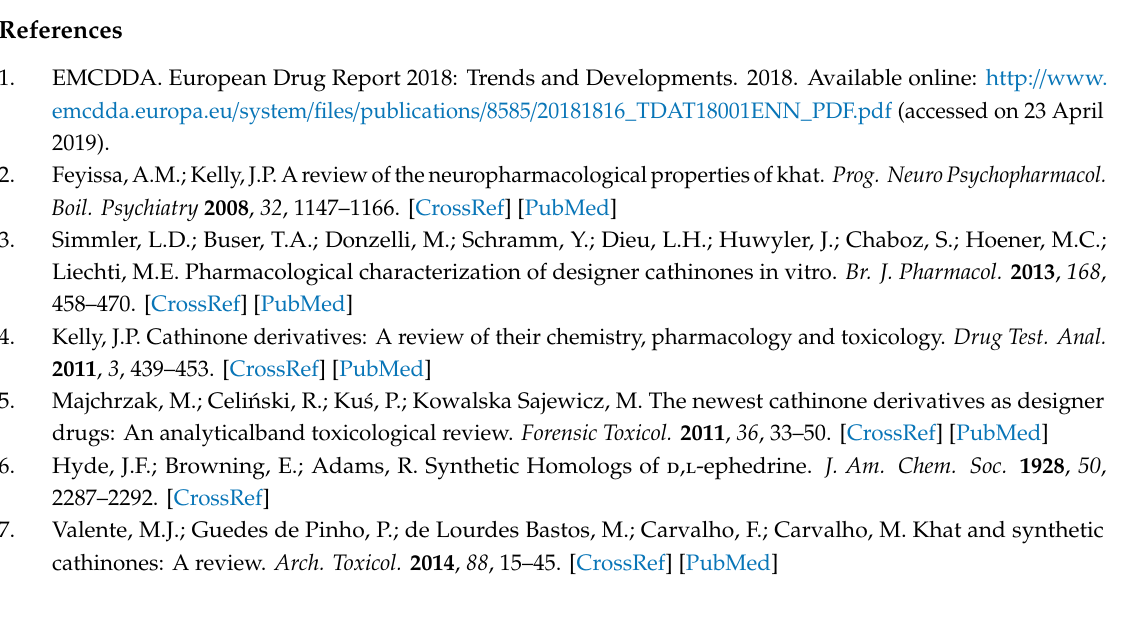
RT; Figure S13: 1H-13C HMQC spectrum of 4F-PHP (3); 500 MHz, DMSO-d6, RT; Figure S14: 1H-13C HMBC spectrum of 4F-PHP (3); 500 MHz, DMSO-d6, RT; Figure S15: 13C NMR spectrum of 3-MEC (4); 126 MHz, DMSO-d6, RT; Figure S16: Total ion chromatogram (TIC) of sample with 4-CDC and IS (A); Mass spectrum of precursor ion (B) and Product Ion Scan with collision energy: − 10 V, − 20V and − 35 V respectively (C,D,E); Figure S17: Total ion chromatogram (TIC) of sample with MDPT and IS (A); Mass spectrum of precursor ion (B) and Product Ion Scan with collision energy: − 10 V, − 20V and − 35 V respectively (C,D,E); Figure S18: Total ion chromatogram (TIC) of sample with 3-MEC and IS (A); Mass spectrum of precursor ion (B) and Product Ion Scan with collision energy: − 10 V, − 20V and − 35 V respectively (C,D,E); Figure S19: Gas chromatography (A) and mass spectrometry data (B) of 4-CDC (1); Figure S20: Gas chromatography (A) and mass spectrometry data (B) of MDPT (2); Figure S21: Gas chromatography (A) and mass spectrometry data (B) of